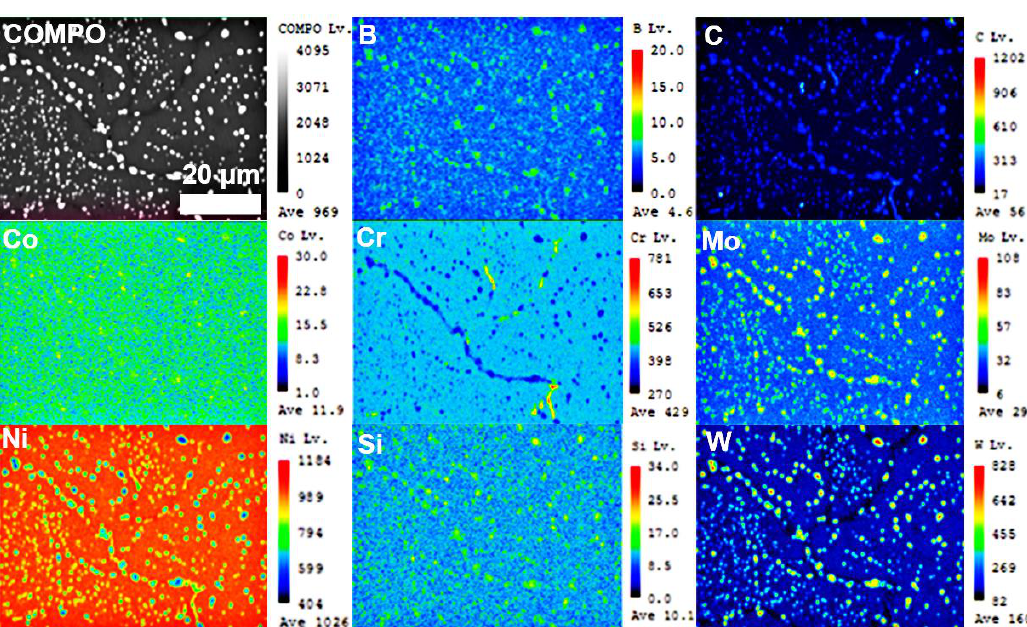
Figure 7. The EPMA results of the CRHA.